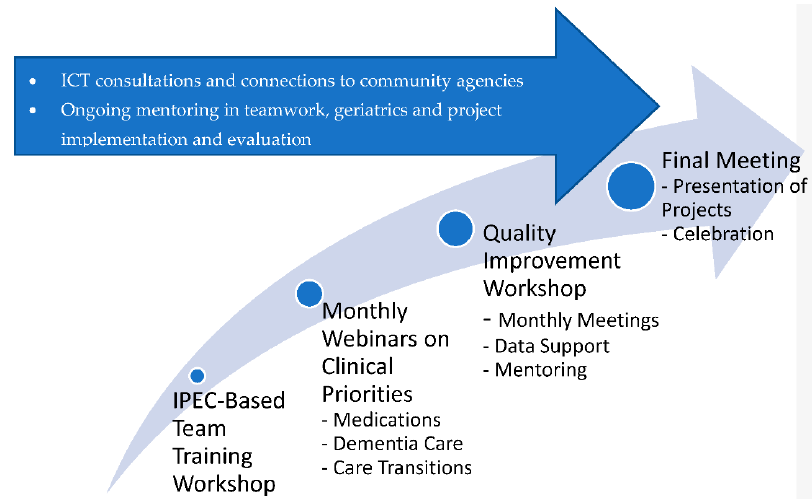
Figure 1. Geriatric Workforce Enhancement Program Primary Care Geriatric Resource Team